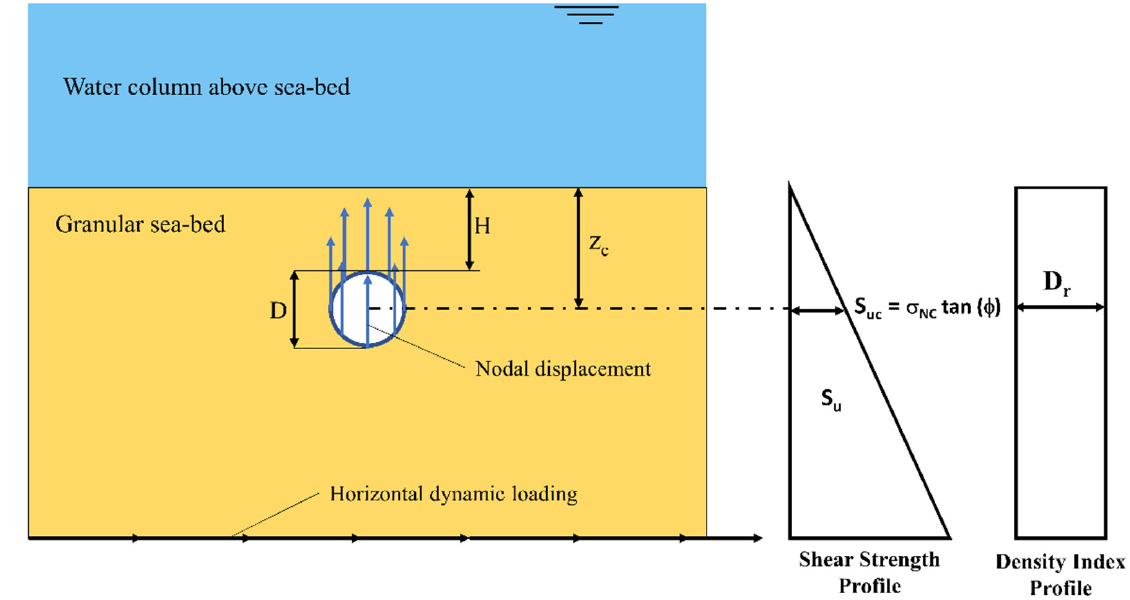
Figure 1. Schematic diagram of the 2D section of the pipeline buried in a granular seabed, and the forces and displacements applied to it.